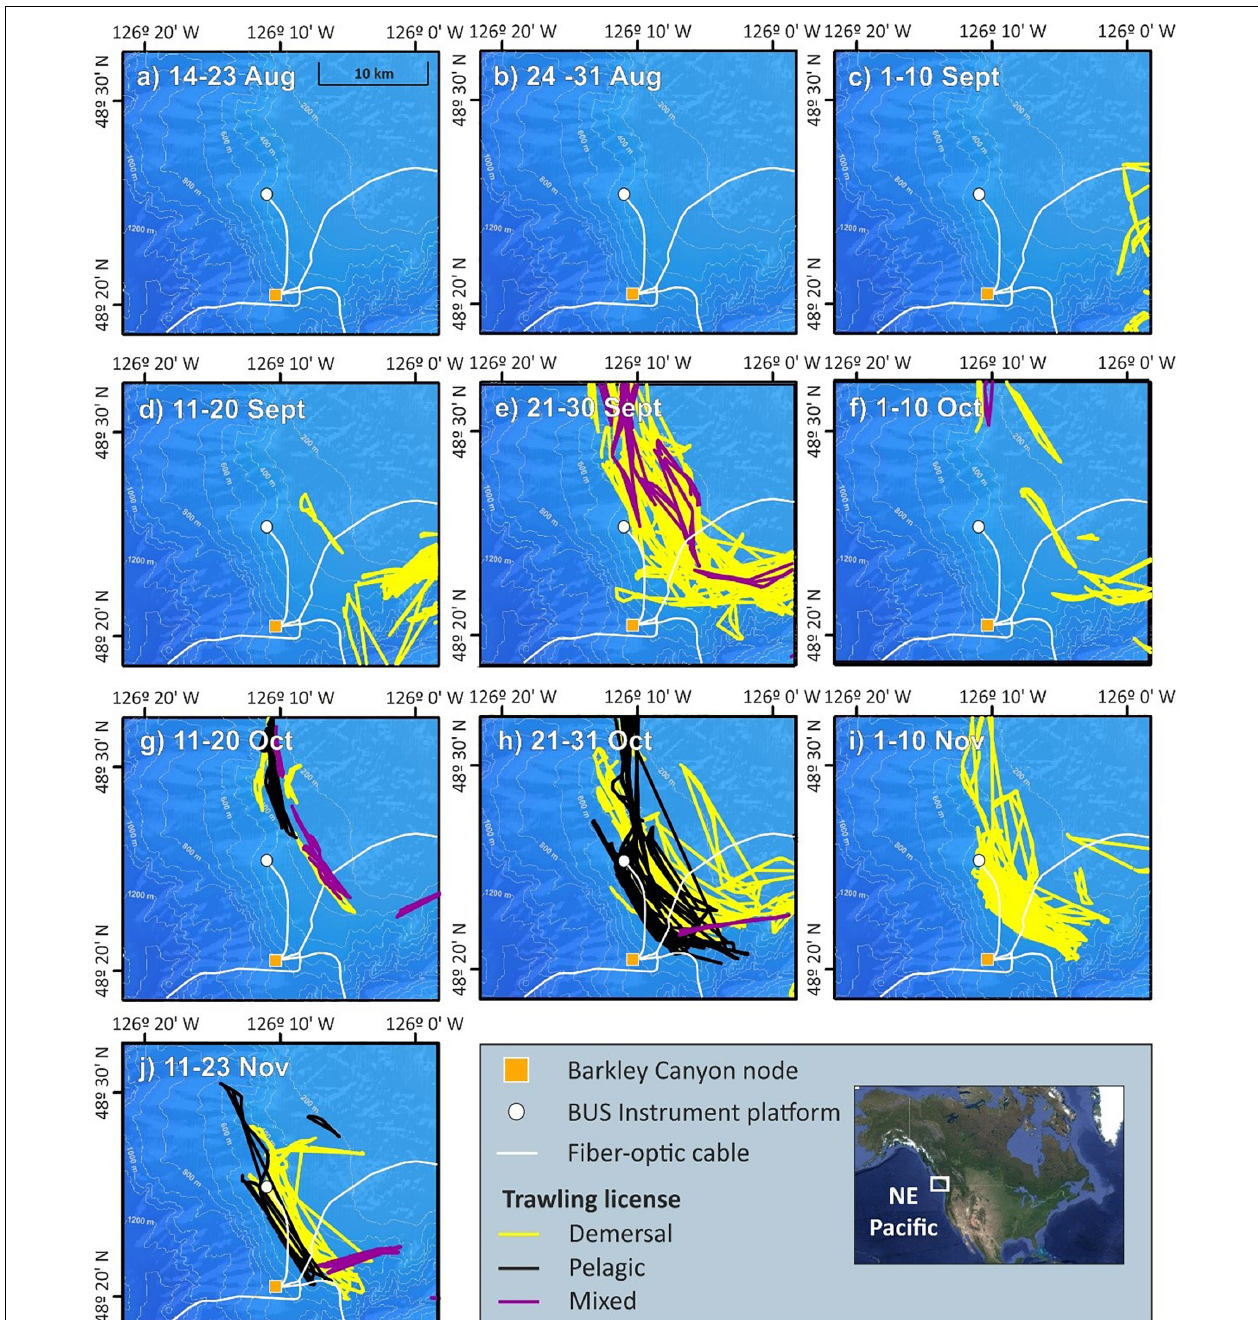
FIGURE 4 | Detailed bathymetric map of the study site showing the variability in the number of hauls for late-summer (a–d) and fall months (e–j) . Yellow lines represent fishing hauls by vessels holding demersal trawl licenses, black lines represent fishing hauls by vessels holding pelagic trawl licenses, and magenta lines represent fishing hauls by vessel holding mixed licenses (i.e., the same vessel can hold both demersal and pelagic trawl licenses). For interpretation of the references to color in this figure legend, the reader is referred to the web version of this article.